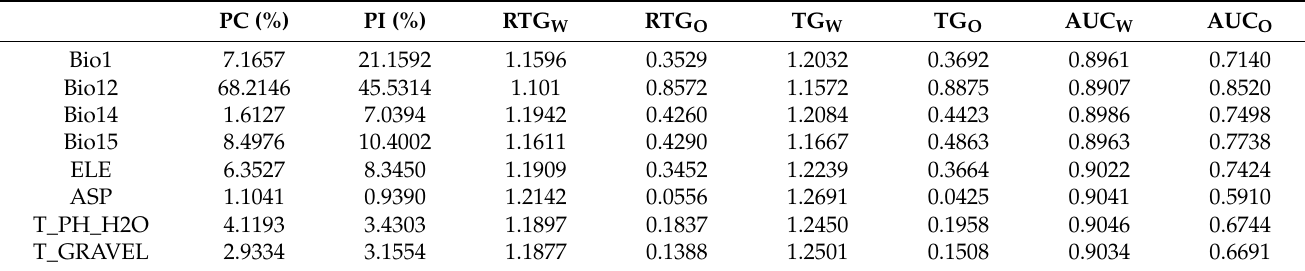
Table 3. The contribution rate and value of gain of climatic variables.